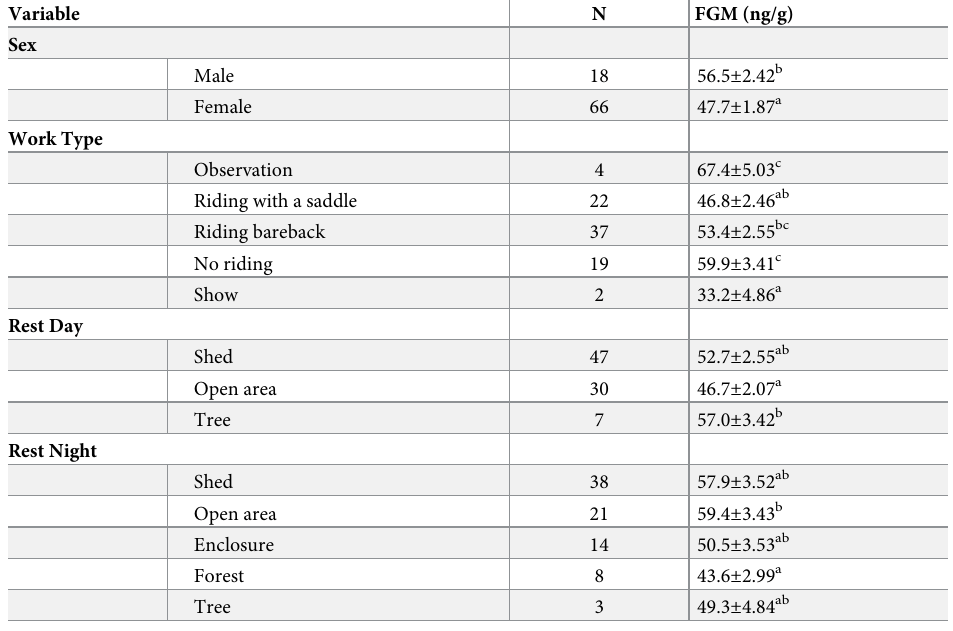
Table 5. LS-mean ( ± SEM) fecal glucocorticoid metabolite (FGM) concentrations of elephants in relation to cate- gorical demographic and management variables from final GEE models.